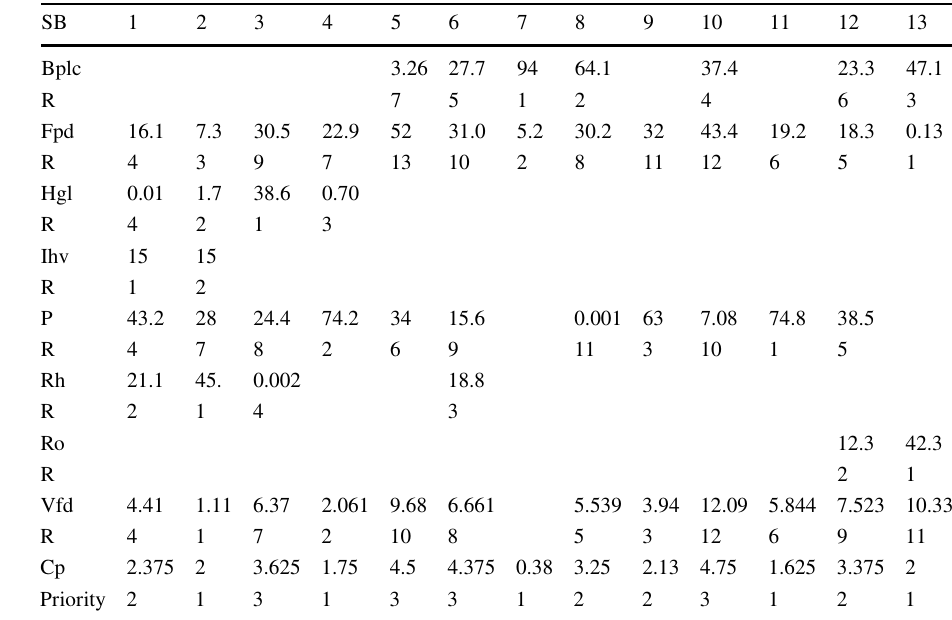
Bplc, buried pediments with lateritic capping; Fpd, flood plain deposits; Hgl, highly gullied land; Ihv, inter- hill valley; P, pediplain; Rh, residual hills; Ro, rocky outcrop; Vfd, valley